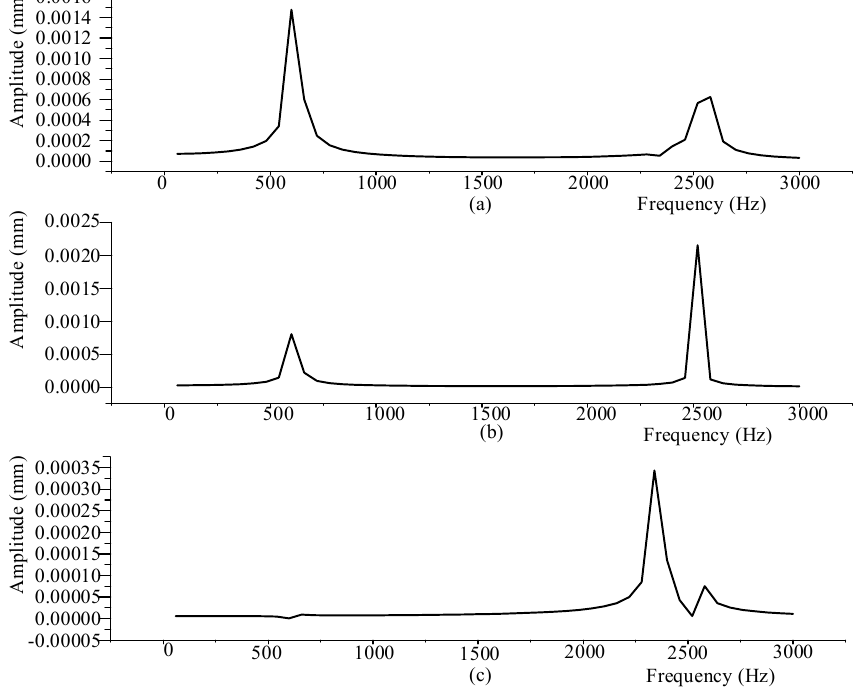
Figure 17. Harmonic response curve of turntable under center loading: ( a ) X-directional harmonic response curve; ( b ) Y-directional harmonic response curve; ( c ) Z-directional harmonic response curve.